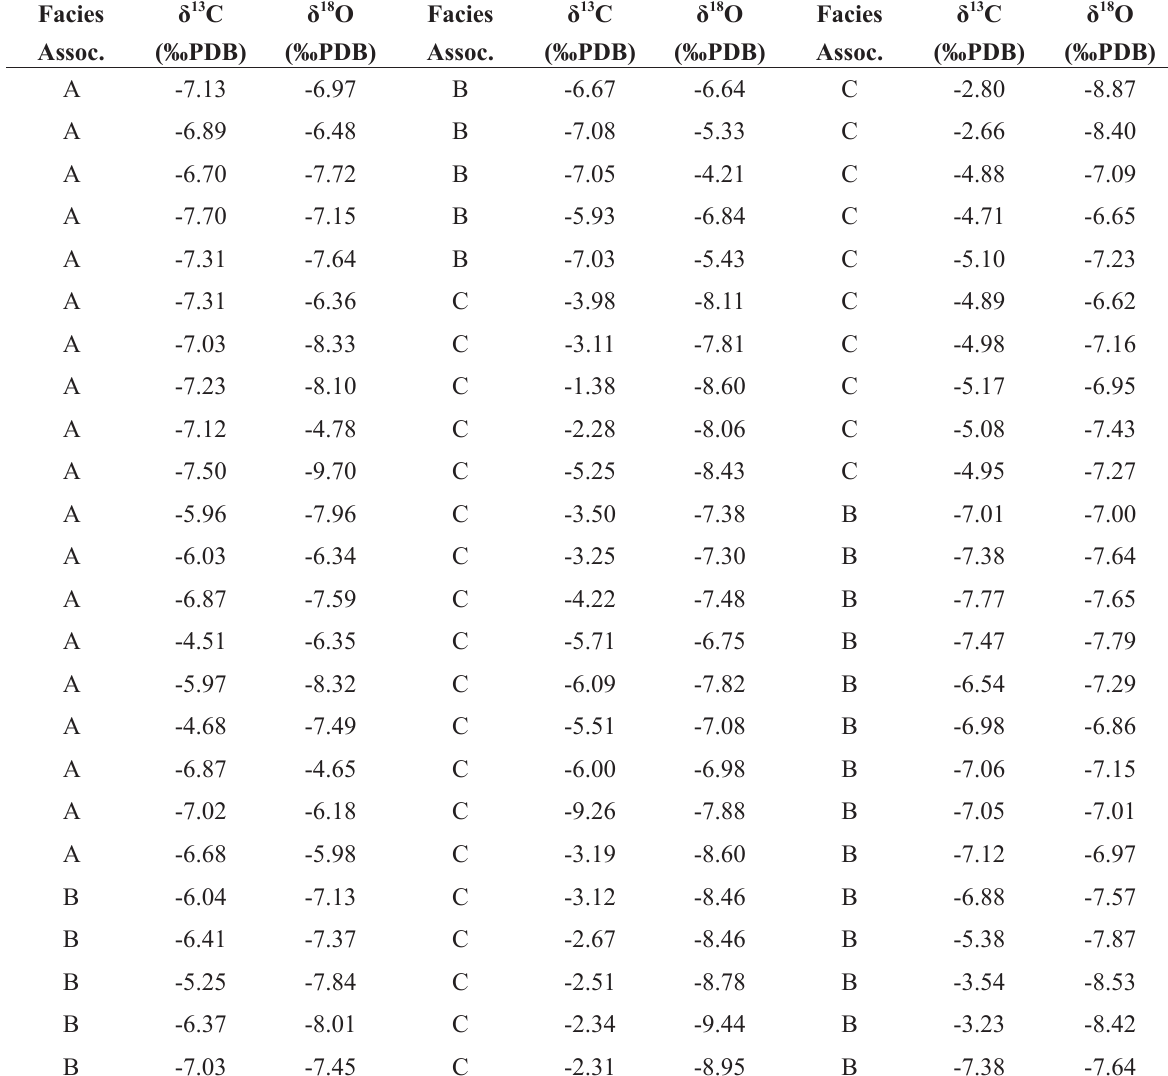
δ 13 C and δ 18 O compositions for different facies associations of Quaternary continental carbonates of Serra da Bodoquena, Corumbá plateau, Serra das Araras and Pantanal do